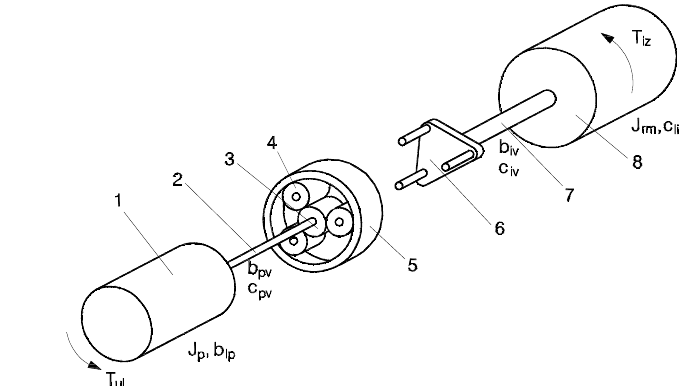
Figure 2 – Planetary gear train model: 1 – driver, 2 – input shaft, 3 – sun gear, 4 – planet gear, 5 – ring gear, 6 – carrier, 7 – output shaft, 8 – working